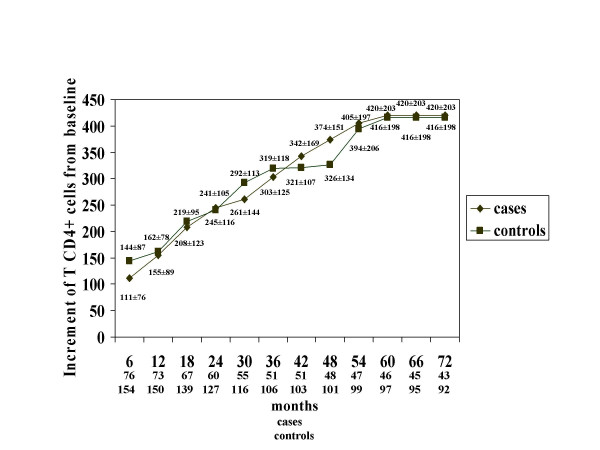
T CD4+ cell count/mmc six month increment (mean ± SD) from the beginning of HAART to the end of the follow-up in cases and controls